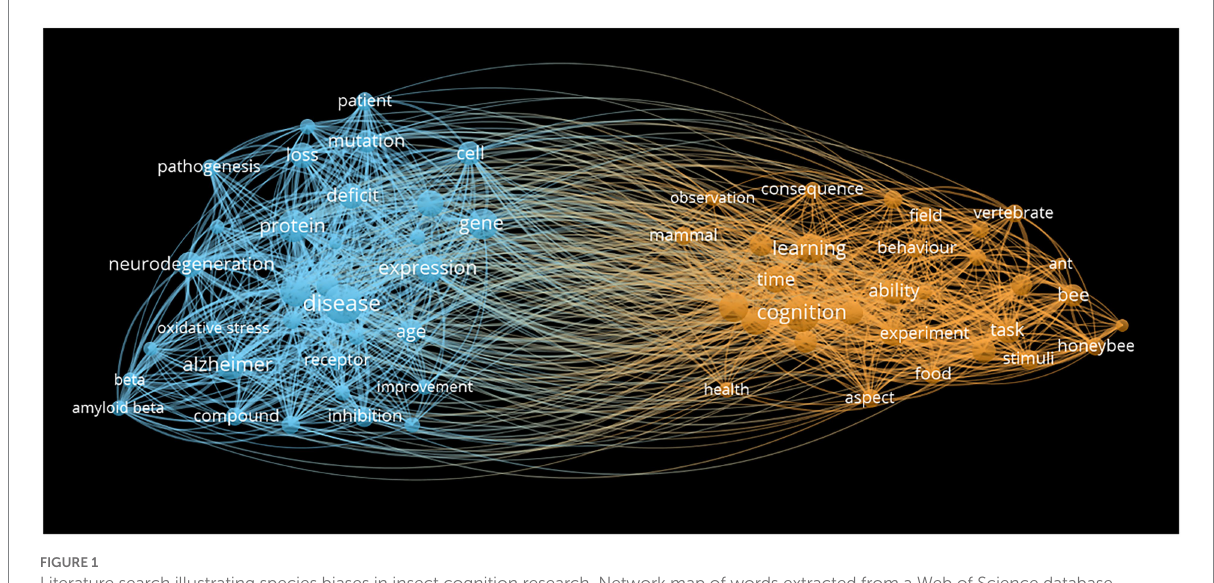
FIGURE 1 Literature search illustrating species biases in insect cognition research. Network map of words extracted from a Web of Science database, downloaded the September 21, 2021 from articles including “insect” and “cognition” either in the title or the abstract. We used VOSwiewer 1.6.16 with binary counting (only the presence or absence of a word counts), including each word that appeared 10 times or more, and removing or replacing irrelevant terms such as plural/singular, homonyms etc (see Supplementary Appendix). In the first cluster (orange), behavioral and learning studies were largely dominated by studies on bees and ants. In the second cluster (blue), molecular biology studies about brain functions were mostly dominated by studies on